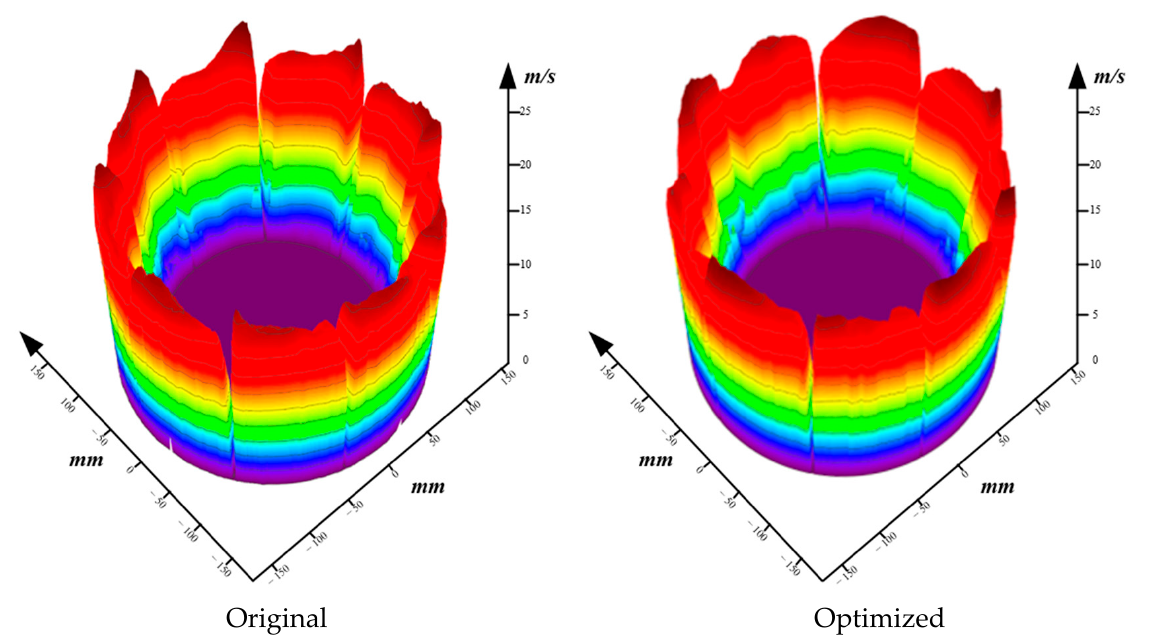
Figure 18. The velocity distribution of the cross-section before and after optimization. Using the Turbo module in the CFD-POST software, the blades are expanded into the fluid domains of the moving and guide vanes. As shown in Figure 19, the 0.5 leaf height cross-section (blue face) of the moving and guide vanes is expanded into a 2D plane.